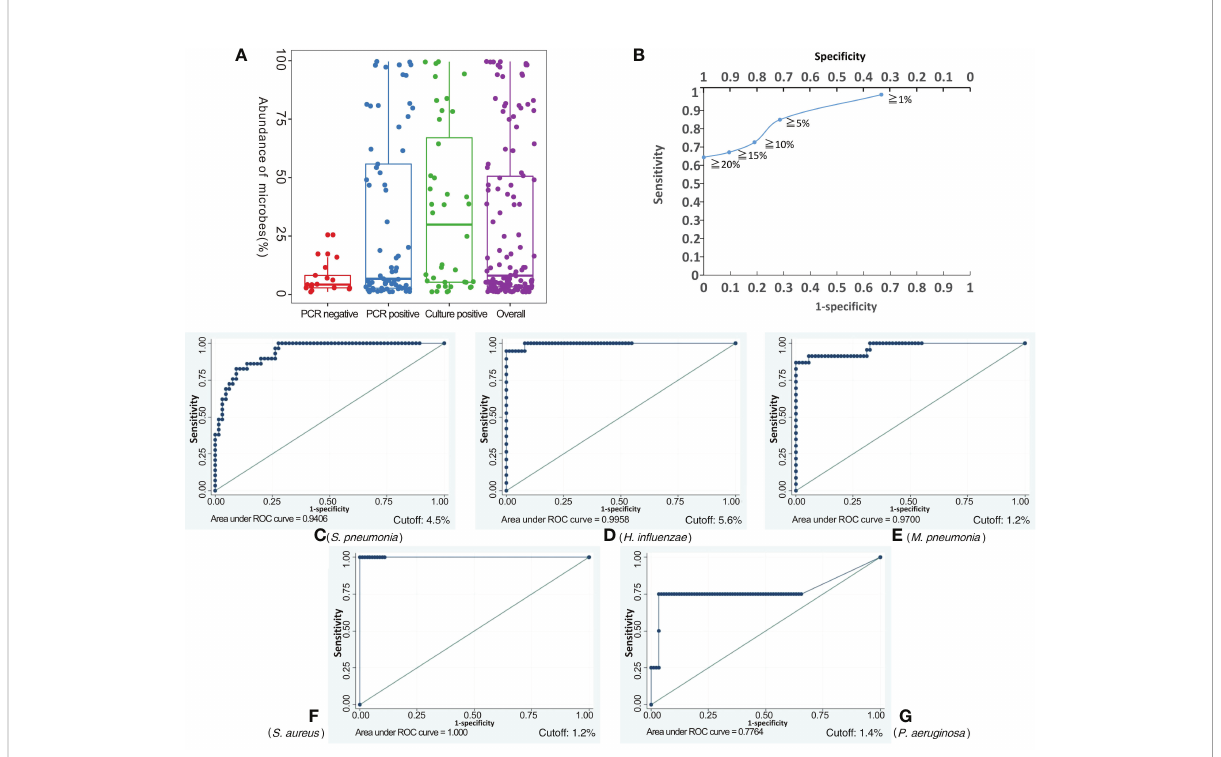
FIGURE 3 Exploring the appropriate NB16S-seq threshold to identify pathogenic bacteria. The relationship between BALF NB16S-seq abundance and positive culture, positive qPCR and negative qPCR results (A) . Correlation between NB16S-seq abundance threshold and sensitivity and speci fi city of BALF pathogen detection (B) . For common respiratory pathogens, an NB16S-seq abundance ≥ 5% is an appropriate criterion to designate a sample positive for a pathogen (C-G) . The relationship between the NB16S-seq abundance threshold and the sensitivity and speci fi city for different strains, S. pneumonia (C) , H. in fl uenza (D) , M. pneumonia (E) , S. aureus (F) , and P. aeruginosa (G) . A value of 4.5% was an appropriate cutoff for S. pneumonia (C) , 5.6% for H. in fl uenzae (D) , 1.2% for M. pneumonia (E) and S. aureus (F) , and 1.4% for P. aeruginosa (G) .